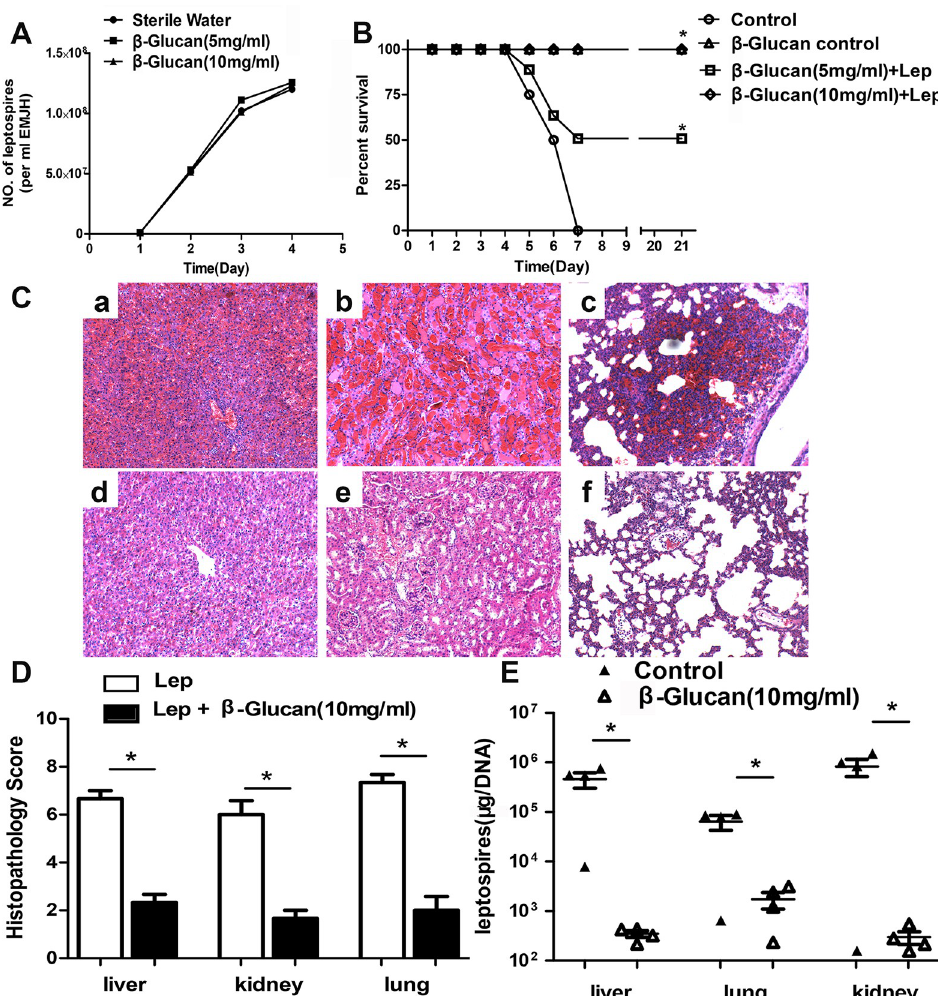
Fig 1. Influence of β -glucan on the pathology of hamsters with leptospirosis. (A) Effect of β -glucan on Leptospira growth. A total of 10 7 leptospires in 1 ml of 0.9% saline supplemented with or without 5 mg or 10 mg of β -glucan were cultured at 29˚C. Growth was analyzed for 4 days by using a Petroff-Hausser chamber and a dark-field microscope. Each data point represents the means ± standard deviations from three independent experiments. P values of < 0.05 were considered significant ( � , P < 0.05). (B) Survival curves of hamsters in the infected control group (n = 8), the β - glucan control group (n = 8) and the group coinjected with leptospires and β -glucan (n = 8). Hamsters were stimulated with β -glucan 1 day prior to leptospira challenge and on day 0 and day 1 during leptospira challenge. � , P < 0.05 versus untreated controls, as determined by Kaplan-Meier analysis with a log-rank test. (C) Histopathology of the kidneys (a and b), livers (c and d), and lungs (e and f) of hamsters in the infected control group (a, c, and e) and the group coinjected with leptospires and β -glucan (b, d, and f). Magnification, 100 × . Samples were collected on the 4 th day after infected leptospira , and representative images are shown. (D) Histopathology scores for kidneys, livers, and lungs of hamsters. The data are presented as the mean histopathology scores for the two groups of hamsters. Statistical analysis of the results for the infected control group (n = 4) and the group coinjected with leptospires and β -glucan was performed by using the Wilcoxon rank sum test. � , P < 0.05. Magnification, × 200. (E) Leptospiral burdens in the kidneys, livers, and lungs of hamsters in the infected control group and the group coinjected with leptospires and β - glucan, as determined by qPCR. Samples were collected on the 4 th day after infected leptospira . The results are presented as the number of genomic equivalents per microgram of tissue DNA, and the differences were compared by one-way ANOVA. � , P < 0.05. kidneys and lungs were selected from the group coinjected with β -glucan and leptospires and from the infected controls. The livers of infected control hamsters showed more inflammatory